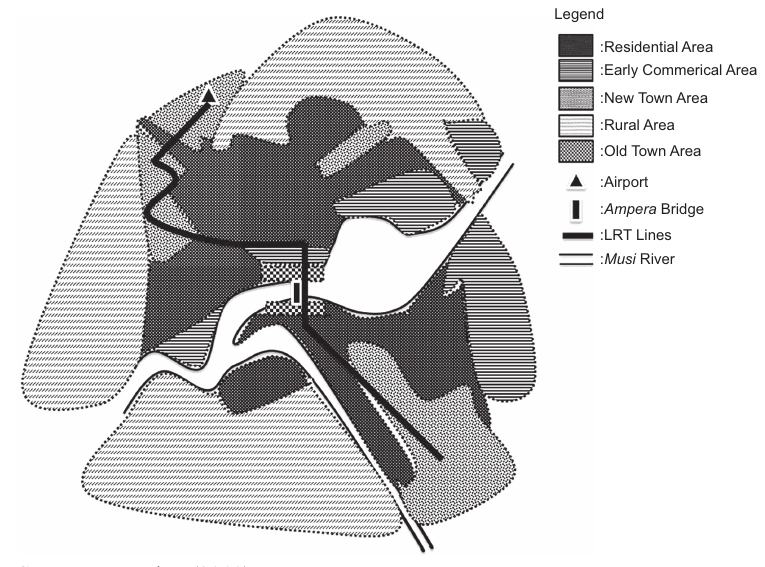
Figure 3. Desakota characteristic map of Palembang city with Palembang LRT